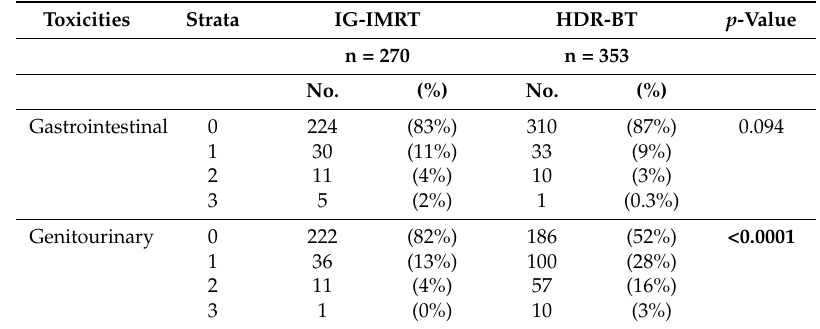
Table 4. Late toxicities according to modalities.